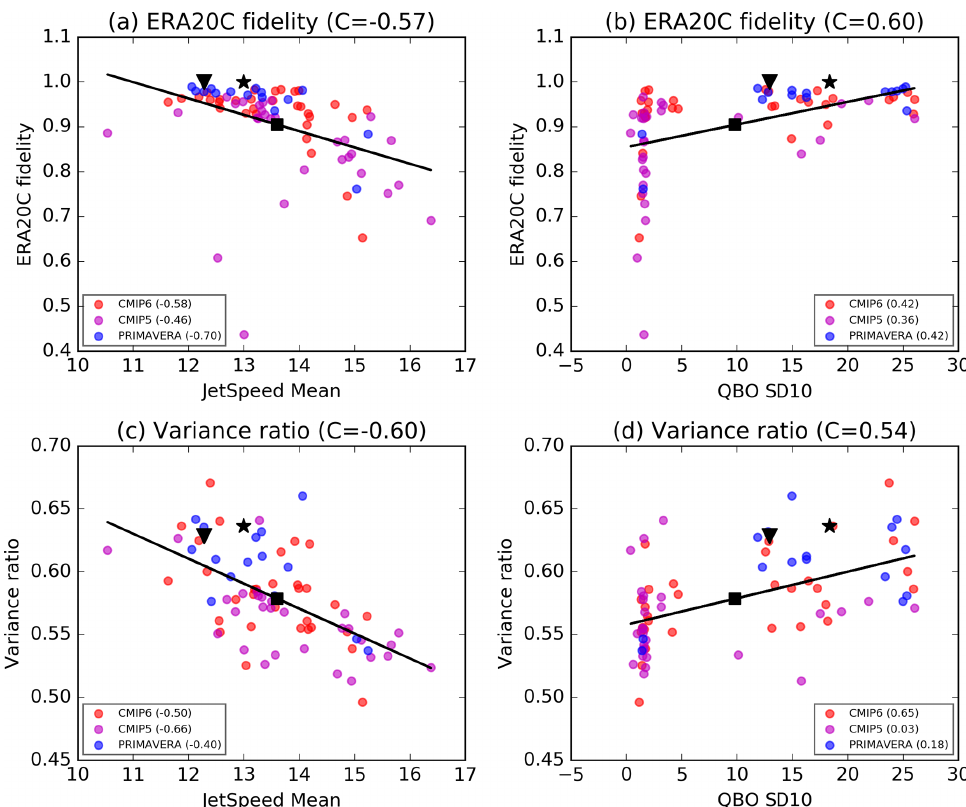
Figure 16. Panels (a) and (c) as in Fig. 15 but showing the covariation between mean DJF jet speed and regime fidelity and variance ratio. Panels (b) and (d) are the same but showing the relationship with QBO standard deviation measured at